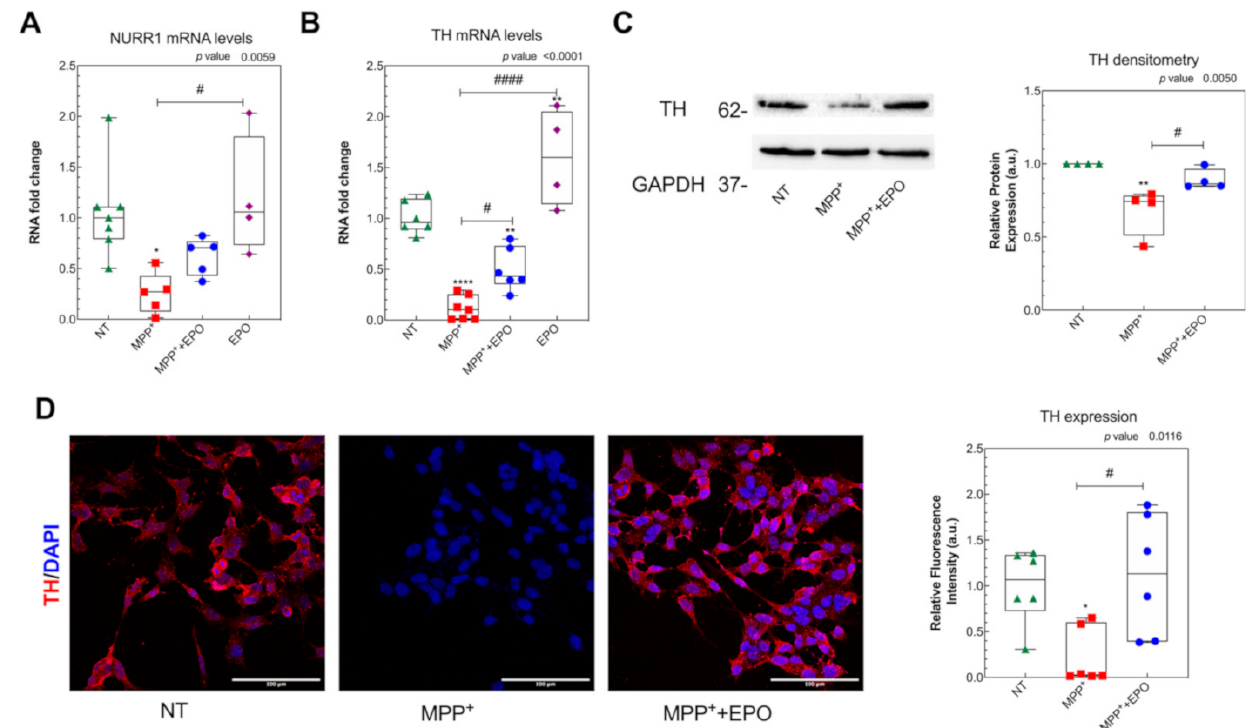
Figure 2. Effect of EPO on the preservation of dopaminergic targets TH and NURR1. The expression levels of NURR1 ( A ) and tyrosine hydroxylase (TH). * p <0.05, # p < 0.05 vs. MPP + ( B ) mRNA were evaluated by Real Time-PCR in SH-SY5Y cells, after 24 h of treatment with MPP + , MPP + +EPO or EPO. GAPDH was used as housekeeping gene. Data are expressed as box-and-whisker plot of 3 replicate values in 3 independent experiments ( n = 9). ** p < 0.01, **** p <0.0001 vs. NT; # p < 0.05, #### p <0.0001 vs. MPP + . ( C ) TH protein expression was evaluated by Western blot in SH-SY5Y cells, after 24 h of treatment with MPP + or MPP + +EPO. The intensity of the band and relative protein expression was evaluated with the software Image-J (NIH). Data reported are presented in a box-and-whisker plot of 4 independent experiments and results are represented as intensity of TH vs. GAPDH, in relation to NT. GAPDH was used as loading control. ** p < 0.01 vs. NT; # p < 0.05 vs. MPP + . ( D ) TH protein expression was evaluated by immunofluorescence analysis in SH-SY5Y cells, after 24 h of treatment with MPP + or MPP + +EPO. Fluorescence quantification and the relative protein expression were performed with the software Image-J (NIH). Scale bar: 100 µ m. Data reported are presented in the form of a box-and-whisker plot (3 fields per experiment, 2 independent experiments; n = 6). * p < 0.05 vs. NT; # p < 0.05 vs. MPP +